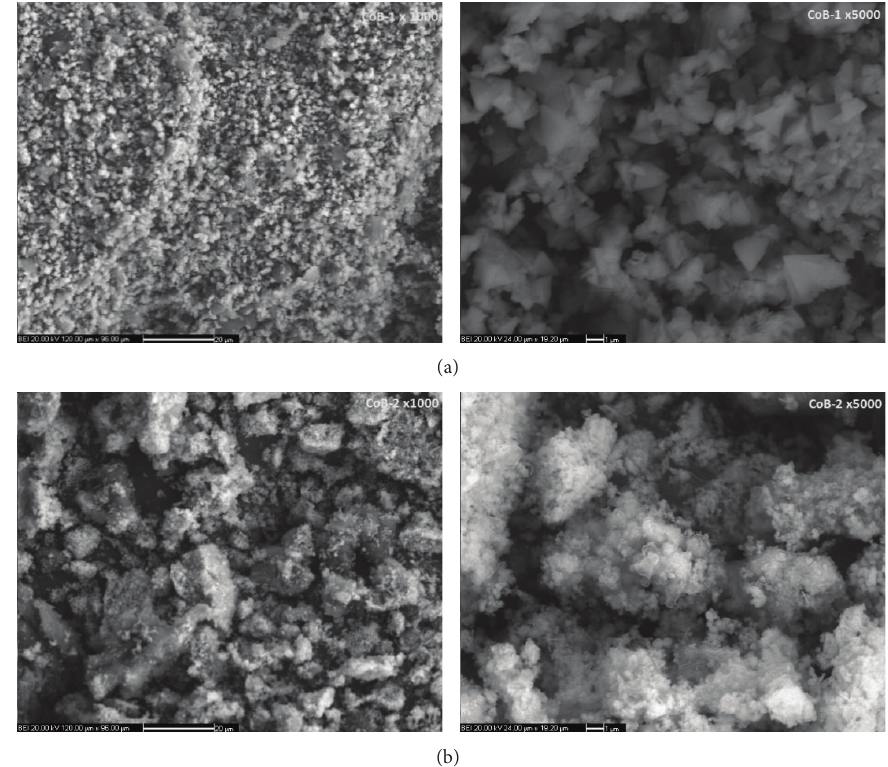
Figure 2: The SEM images of Co-B catalysts with × 1000 (left) and × 5000 (right) magnification; (a) CoB-1 catalyst, (b) CoB-2 catalyst.